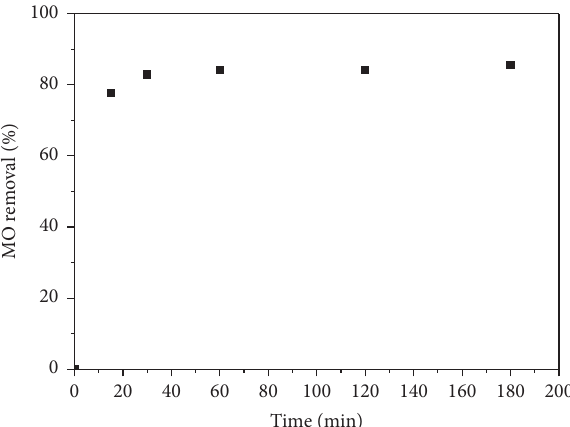
Figure 7: Effect of contact time on the adsorption of MO ( C coefficient R 2 , and its calculated equilibrium adsorption capacity ( q ) is closer to the experimental value e,cal � 5.32 mg/g which corresponds to 84% of MO ( q e,exp